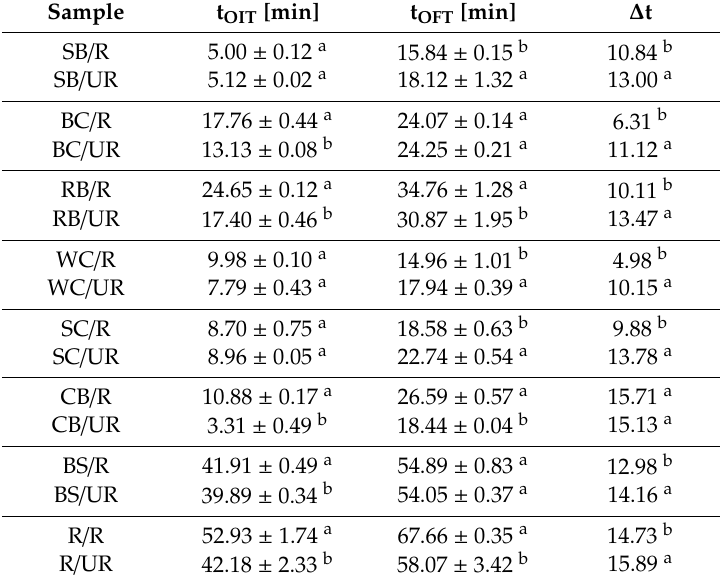
Table 3. Di ff erential scanning calorimetry (DSC) oxidation induction time (t OIT ), and oxidation final time (t OFT ) of oils pressed from unroasted and roasted